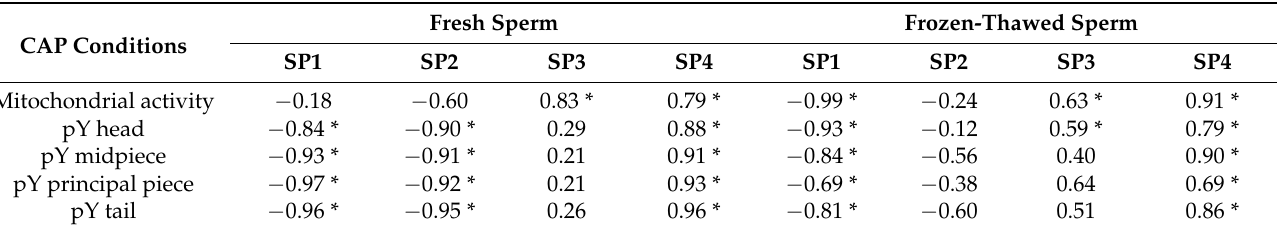
Table 2. Correlation coefficients between the percentage of motile sperm subpopulations (SP), spermatozoa with active mitochondria (mitochondrial activity) or with tyrosine phosphorylation (pY) during capacitating (CAP) conditions. Correla- tions were estimated separately in fresh and frozen-thawed spermatozoa considering all incubation times in CAP conditions in the three